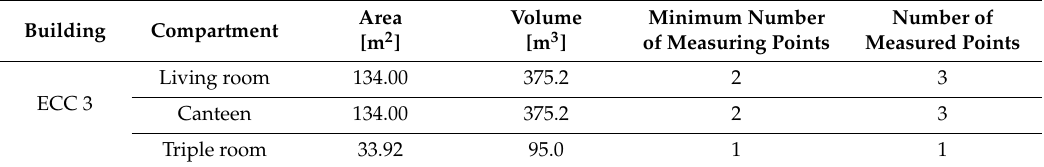
Table 7. Minimum number of measurement points per